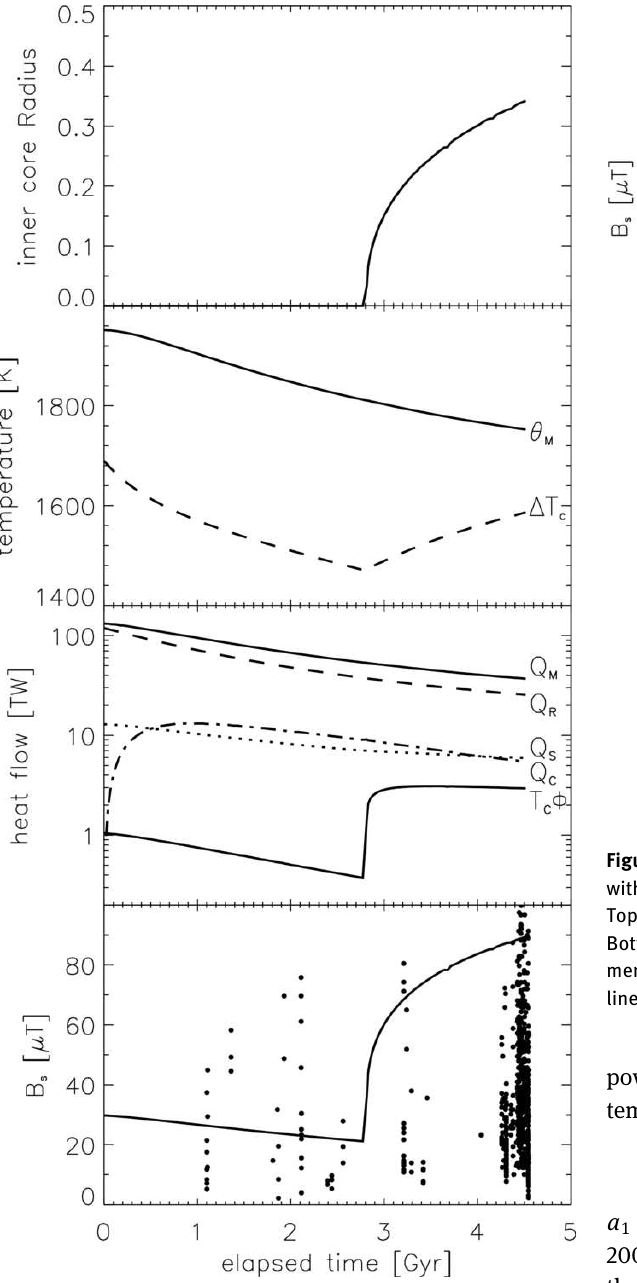
Figure 4. Evolution of the Geodynamo. Top to bottom: 1) Inner core to outer core ratio. 2) Mantle potential temperature θ (solid) and M temperature contrast across the CMB ∆ (dashed). 3) Total sur- CMB face heat fluxes: Q (solid), Q (dashed), Q (dot-dashed), Q M R CMB S (dotted) and ΦT is the convective power Q , available for the c conv dynamo action (dash-triple-dotted). 4) Average surface magnetic field, the black dots are 606 measurements taken from the IAGA paleointensity database (Biggin et al. 2009) and three recent mea- surements in 3.45 Ga rocks form Herrero-Bervera and Valet (2009); Tarduno et al. (2010). (Figure from GA10, with permission of the author).